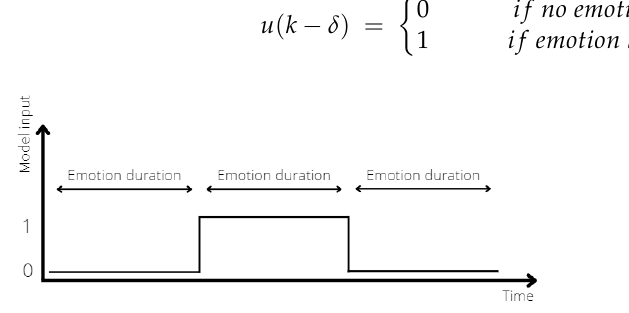
Figure 4. Step input to the SISO TF model.